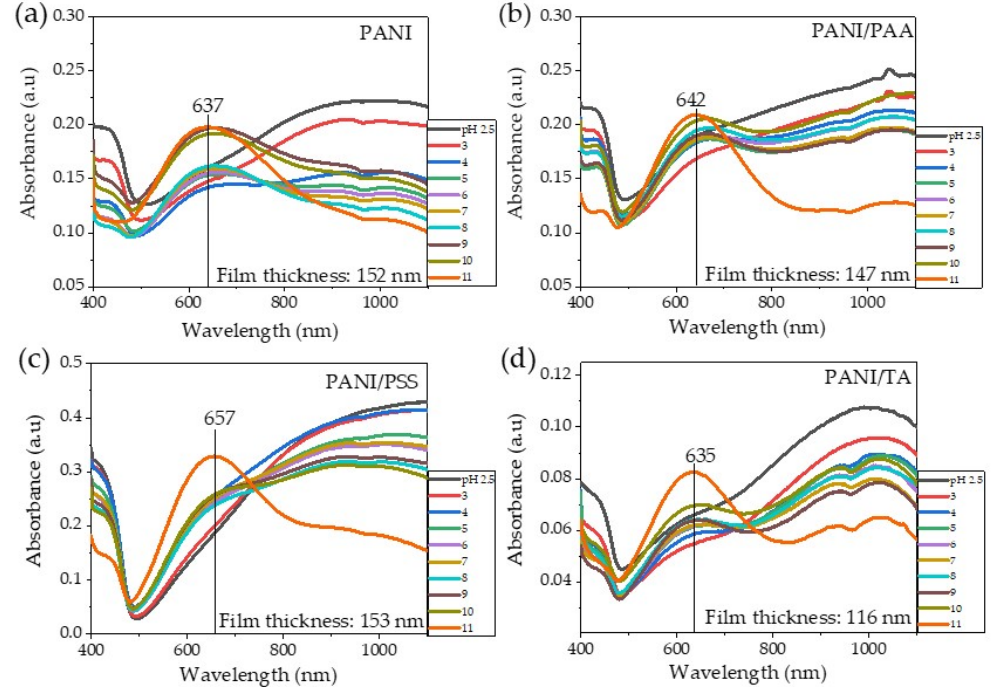
Figure 5. ( a ) UV–Vis spectra of PANI homopolymer, ( b ) PANI/PAA, ( c ) PANI/PSS, ( d ) and PANI/TA LbL films at different levels of pH in water.